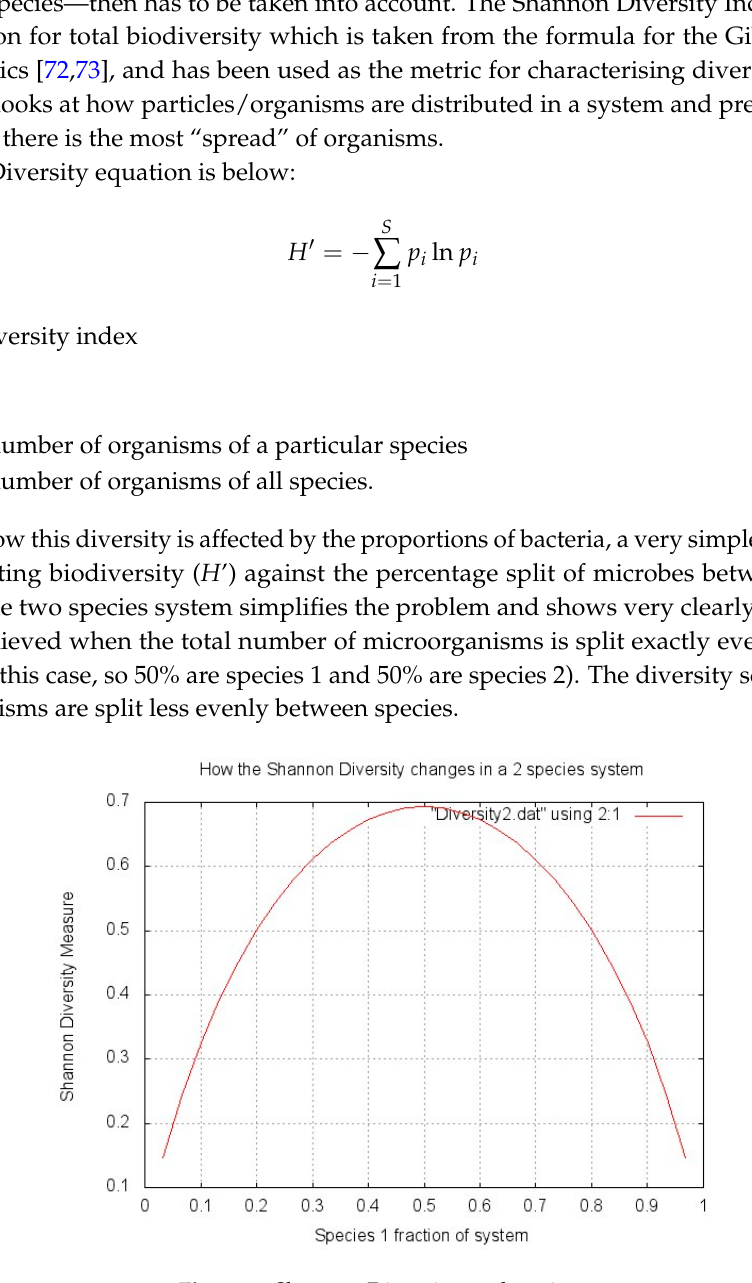
Figure 1. Shannon Diversity explanation.